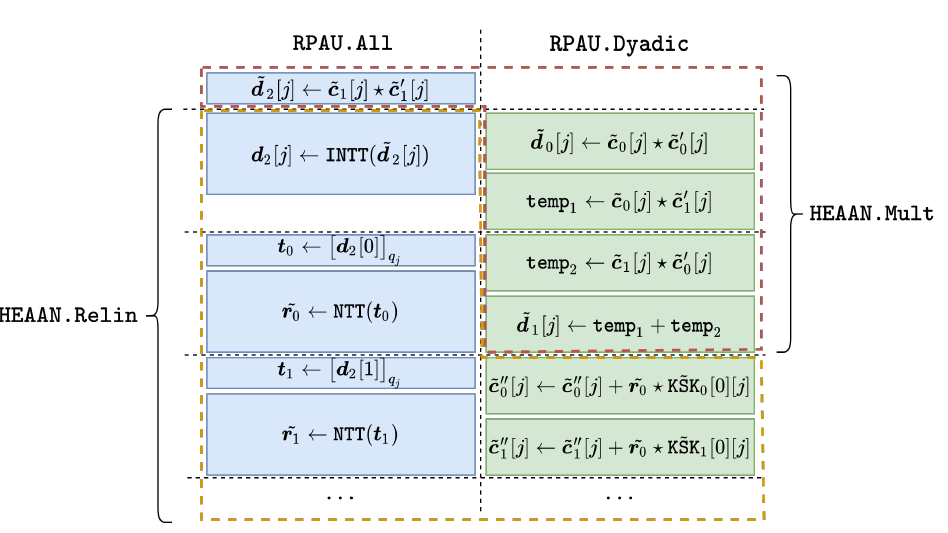
Figure 5: Parallel processing of HEAAN.Mult and HEAAN.Relin using two threads inside j -th